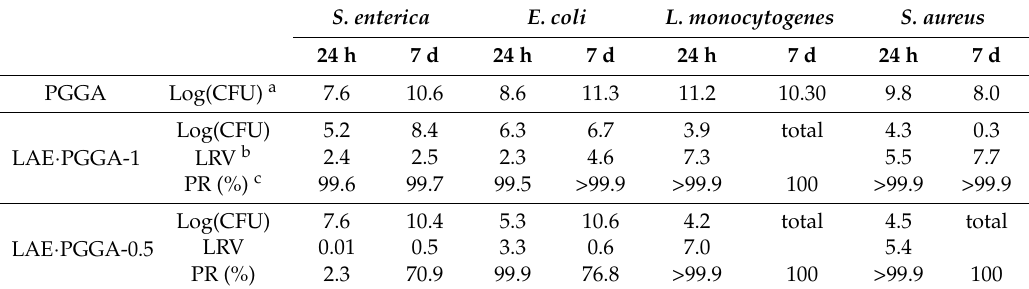
Table 4. Bactericide activity of films made of LAE·PGGA complexes against Gram-negative and Gram-positive bacteria after 1 and 7 days of incubation at pH 7.4 and 37 °C.